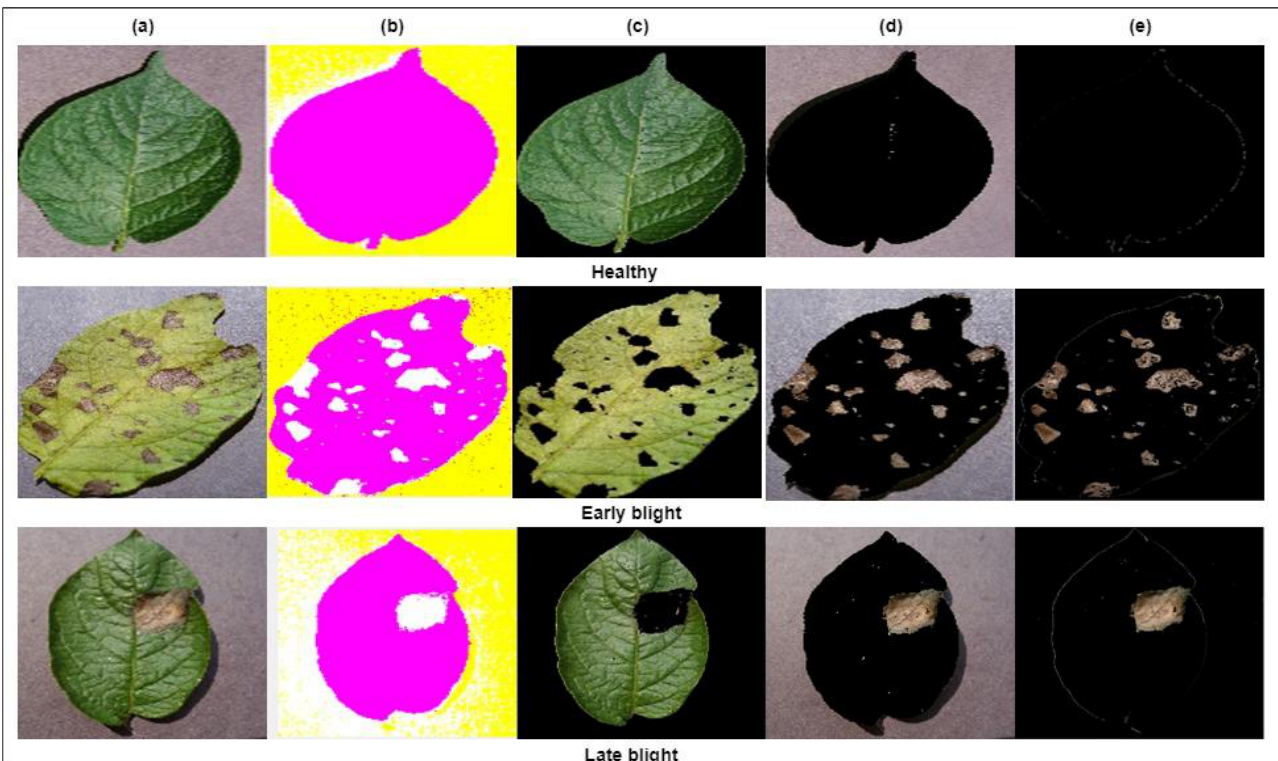
Fig. 3. (a) Original RBG Image of healthy, Early blight and Late blight (b) RGB to CIE-Lab Conversion (c) k-means first Segment (d) K-means Second Segment (e) Background